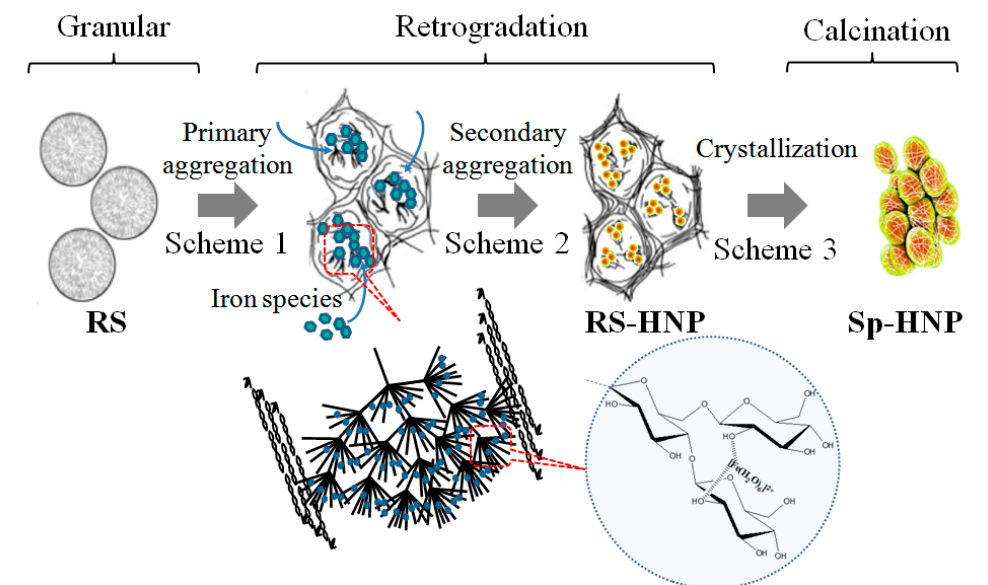
Figure 8. Schematic formation of the Sp-HNP through RS-assisted synthesis.